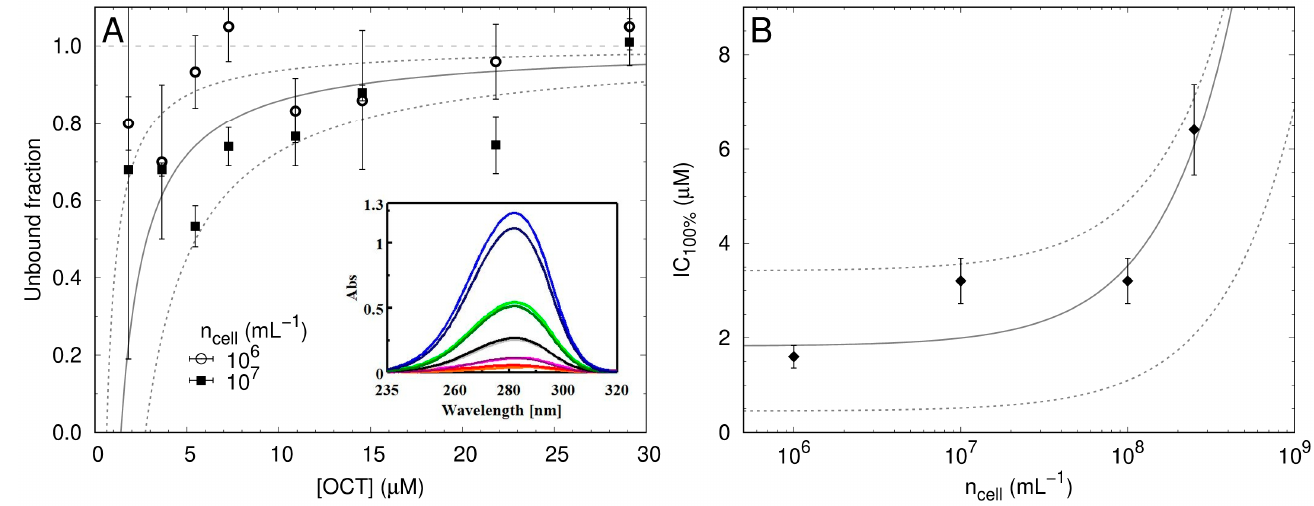
Figure 3. Estimating the number of OCT molecules binding to an E. coli cell. ( A ). The unbound fraction of OCT water as estimated by 281 nm after exposure to 1 × 10 6 and 1 × 10 7 cells/mL dissolved in PBS. OCT was applied at concentrations in the range where it exerts antimicrobial activity against E. coli and above the IC 100% (IC 100% for 1 × 10 6 CFU/mL and 1 × 10 7 CFU/mL in PBS buffer is 2 mg/L). The insert shows absorbance spectra of OCT at 281 nm. The lowest spectra correspond to the lowest OCT concentrations and their absorbance intensity increased with increasing OCT concentrations. In the presence of bacterial cells, the slightly lower absorbance in all spectra was observed indicating association of OCT with bacteria. Measurements were performed at least three times. To obtain the number of molecules per cell, the bound (partitioned) fraction is calculated by subtracting the unbound (free) fraction from the overall OCT concentration. In this case, the bound fraction is proportional to bacterial concentration, and results in an estimate of 1–2 × 10 8 OCT molecules per single cell at IC 100% . ( B ) IC 100% values as a function of cell concentration. MIC or IC 100% corresponding to OCT ´ s concentration where no bacterial growth was observed, were calculated from growth curves recorded in MHB for OCT water in presence of different bacterial concentrations (1 × 10 6 , 1 × 10 7 , 1 × 10 8 and 2.5 × 10 8 CFU/mL). To obtain the number of molecules per cell, the overall OCT concentration is divided in bound and unbound fractions. Free OCT is independent of cell concentration and is revealed at low bacterial presence (about less than 2 mM [1.2 mg/L]). The steep increase of IC 100% instead is due to the bound OCT fraction. It is linear with cell concentration and enables the extraction of OCT molecules bound on a single cell (it is around 1 × 10 7 ). Solid lines are the best data fits, and dashed lines enclose the area accounting for the level of